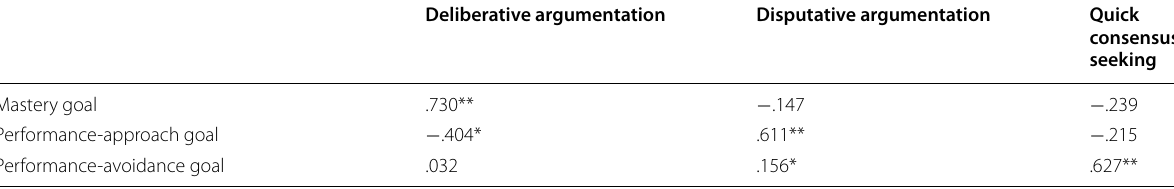
Table 3 Correlation between the achievement goal and discourse style